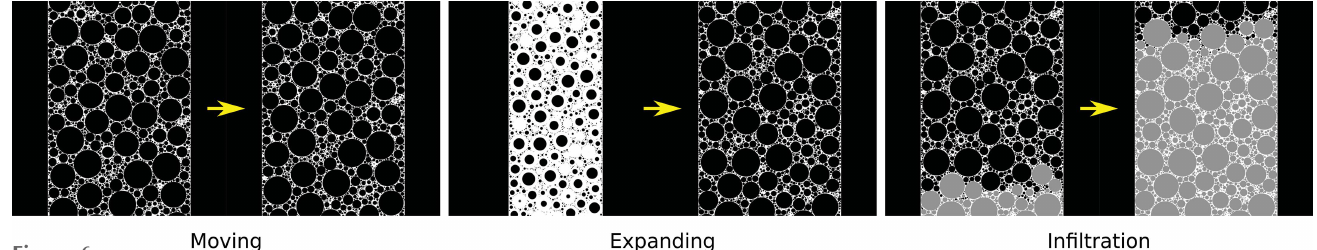
Figure 6 Examples of 4D extensions to the static 3D foam phantoms. In each case, an early time-point is shown on the left, and a later time-point is shown on the right. Given are an example of a moving phantom, in which the foam moves vertically, an expanding phantom, in which the voids grow in size, and an infiltration phantom, in which the voids fill with a different material over time.